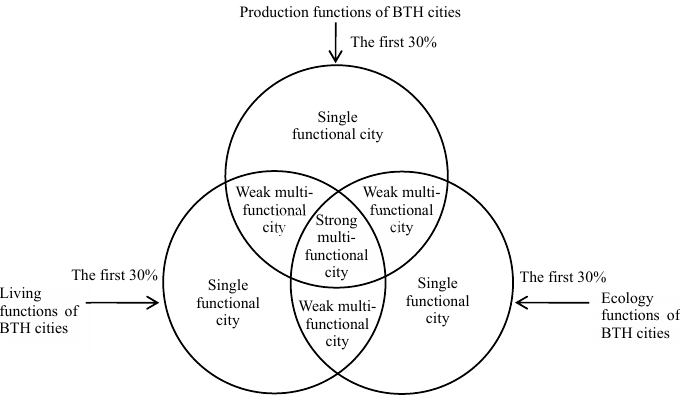
Figure3. Theflowchartaboutassessingadvantageousareasofproduction-living-ecologylandusefunctions.